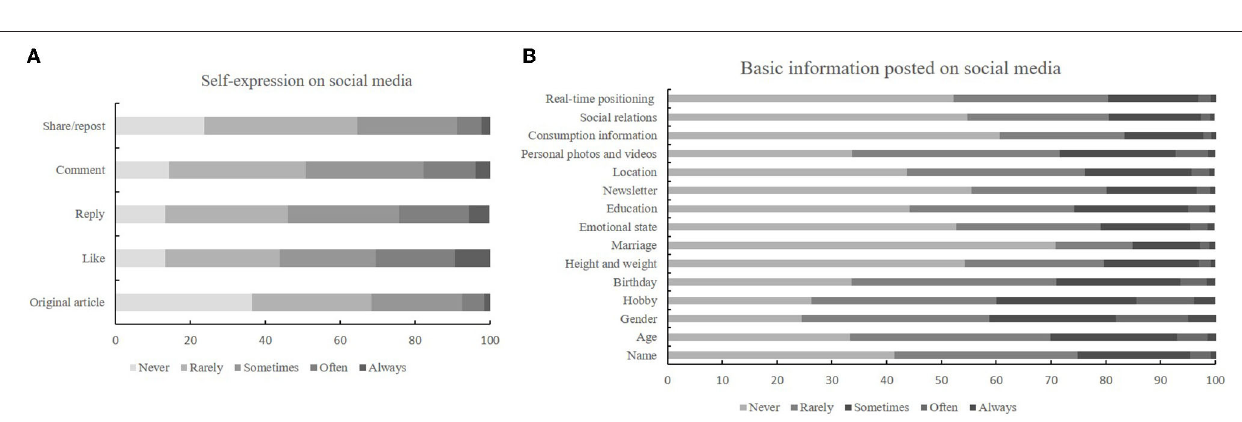
Frontiers in Psychiatry |